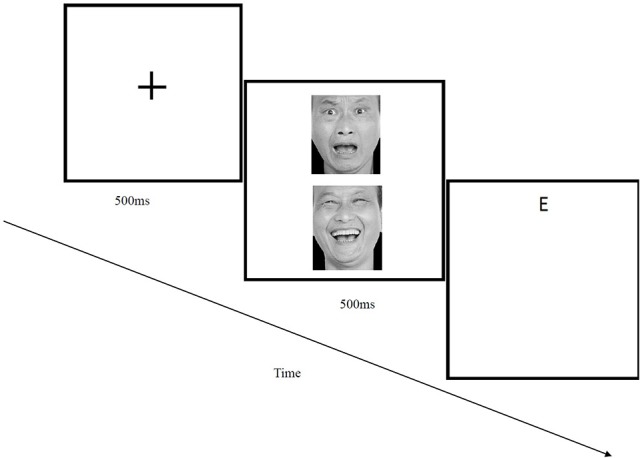
Example of a single trial for the dot-probe attention bias assessment.